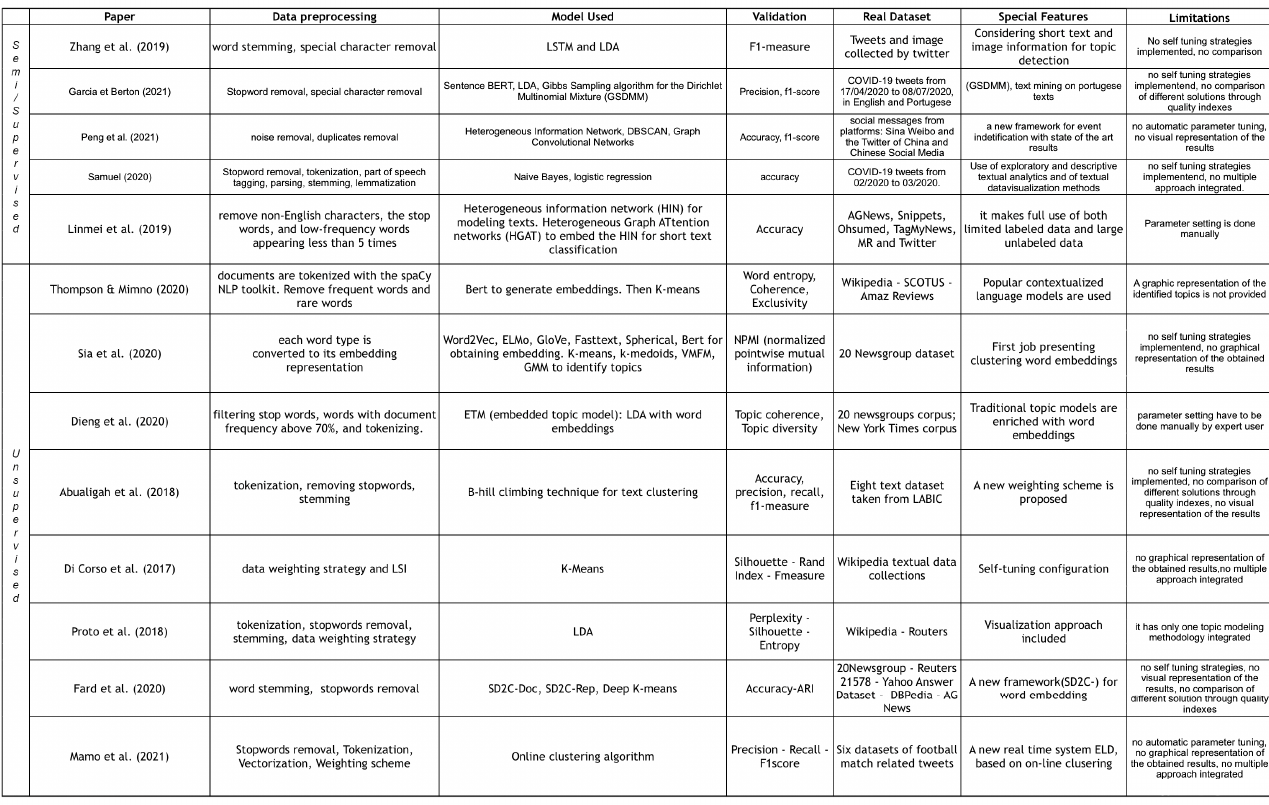
Figure 1. Overview of related works